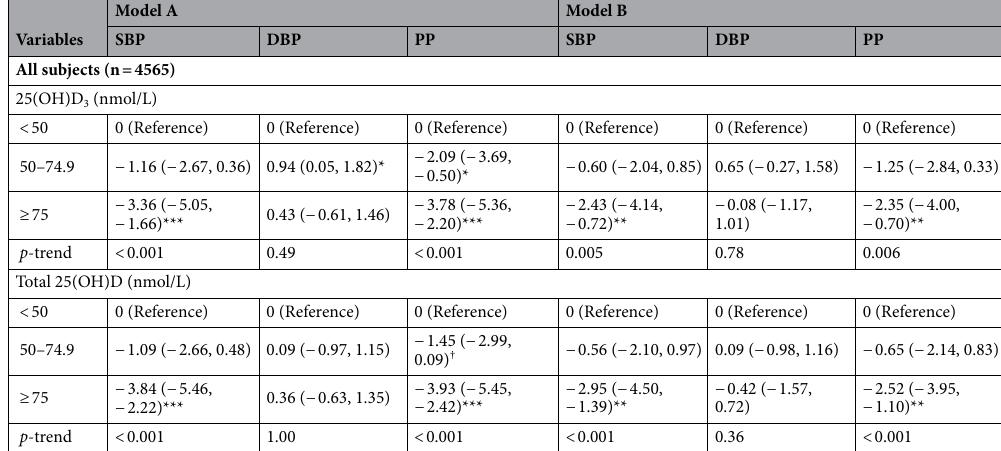
Table 2. Adjusted multiple linear regression and 95% CIs of blood pressure by vitamin D concentrations in all subjects aged ≥ 50 years. Model A was adjusted for age, sex, and race/ethnicity. Model B: Model A + further adjusted for education, season of examination, physical activity, alcohol consumption, smoking status, dietary covariates (intakes of total energy, potassium, calcium, magnesium, and sodium), height, weight, and diabetes.